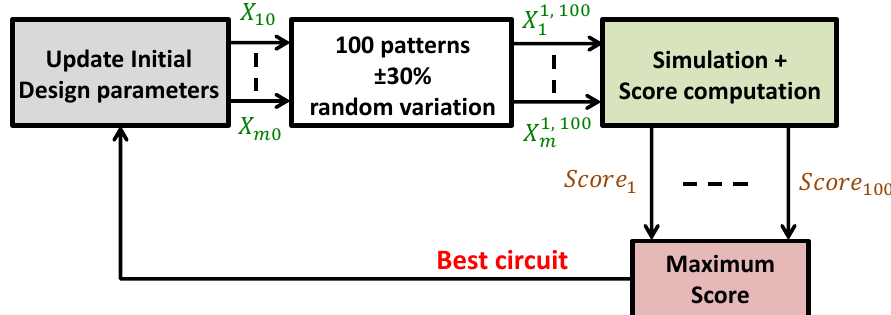
Figure 3. Description of the training-dataset-generation approach used in